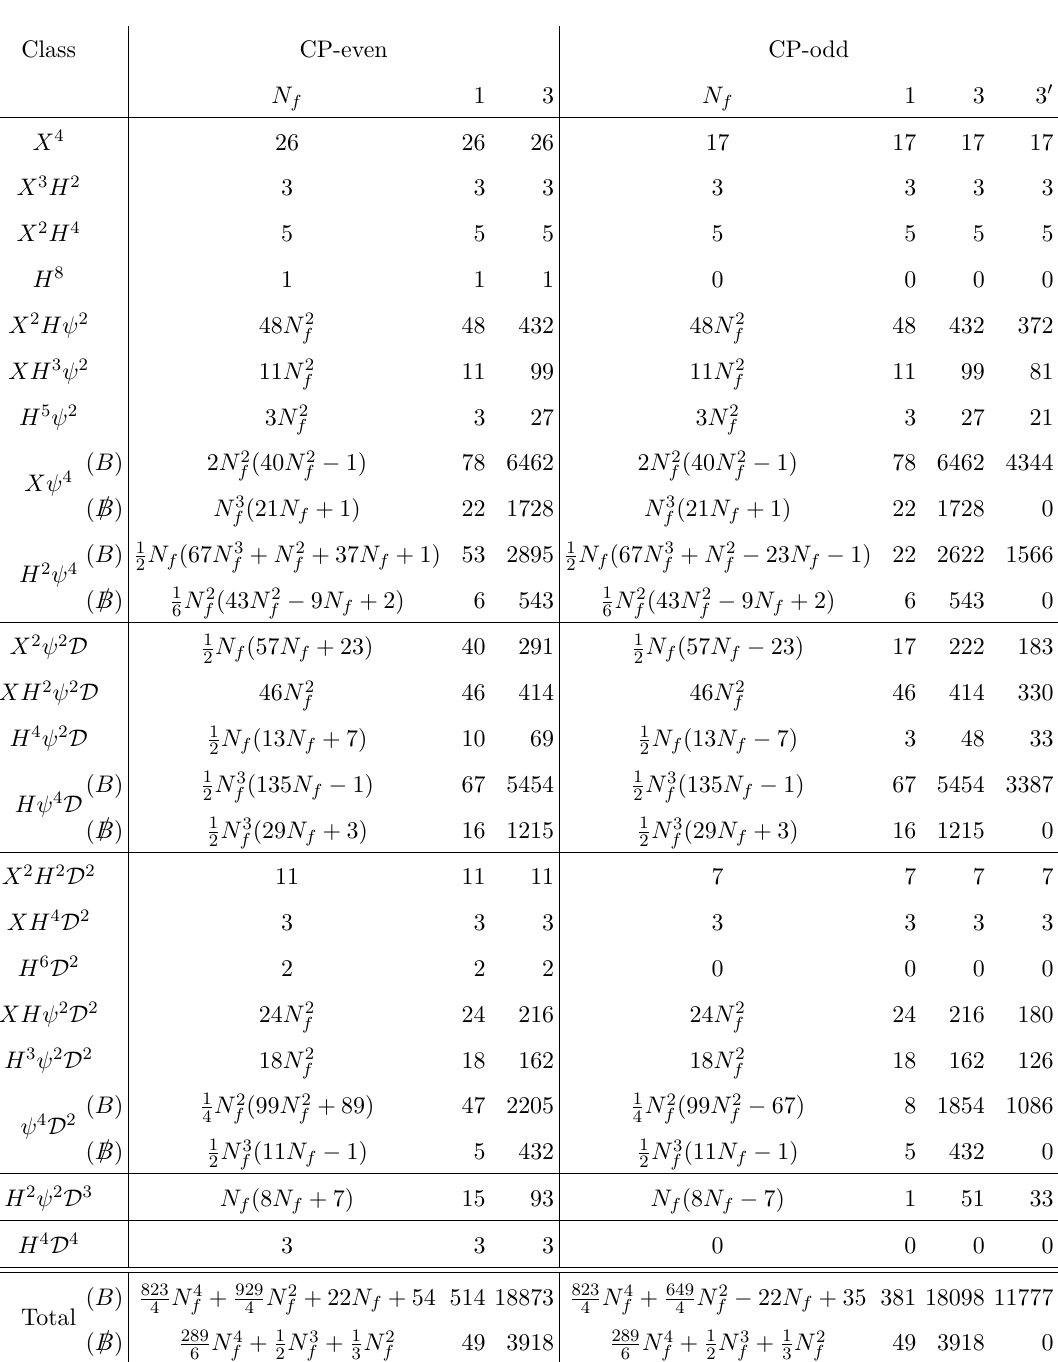
Table 2 . The number of dimension-eight operators for arbitrary N f as well as for N f = 1 and N f = 3 . The horizontal lines separate the operators according to the number of derivatives